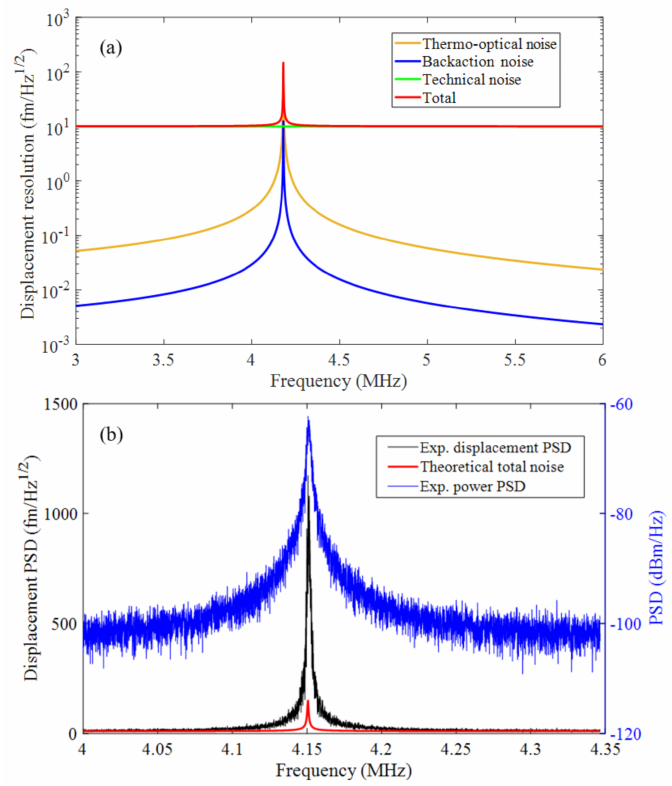
Figure 9. Noise analysis of the optomechanical coupled PCN cavity. ( a ) Theoretical calculation of the frequency response of different noise sources; ( b ) experimental noise around the IP1